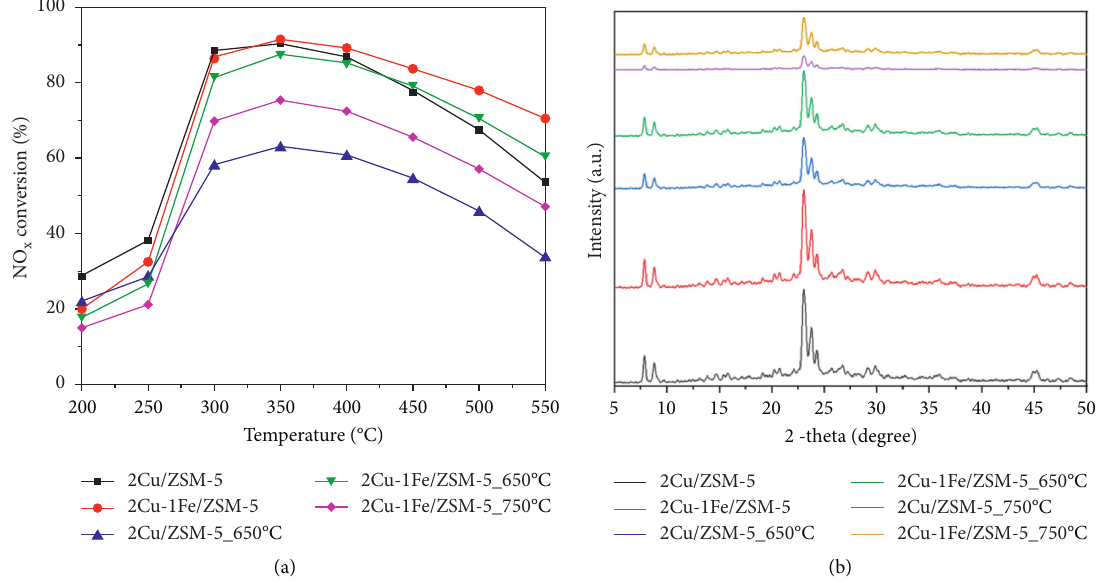
Figure 11: (a) NO x conversion of Cu/ZSM-5 and Cu-Fe/ZSM-5 after hydrothermal aging and (b) XRD patterns of fresh and hydrothermal aging catalysts.